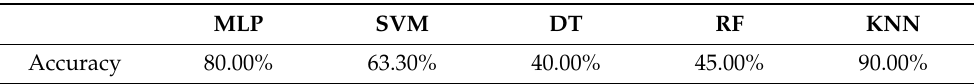
Table 8. Classification results for Dataset 05 (diesel factory worker/control).